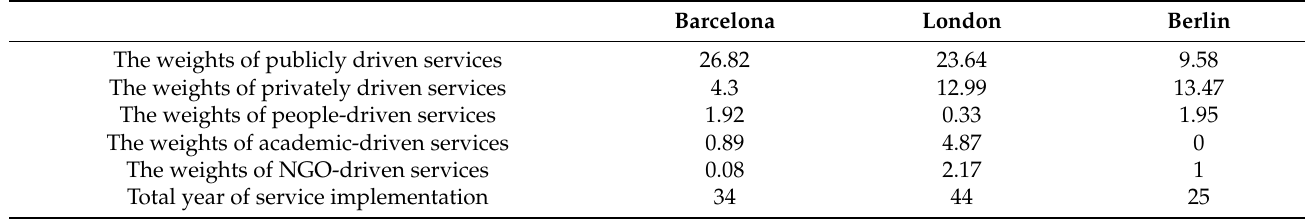
Table 5. Three types of services’ sustainability by different stakeholders’